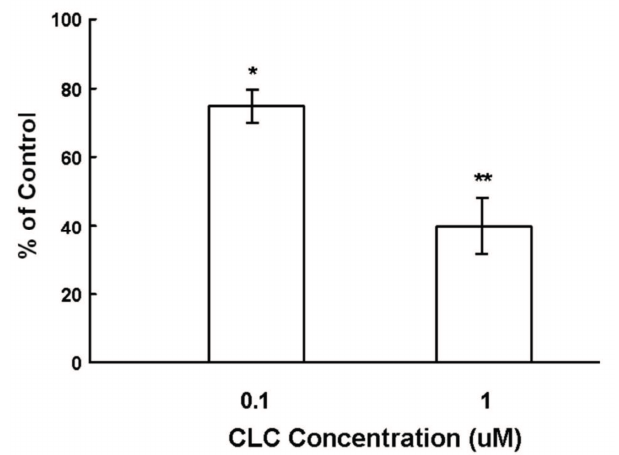
Figure 1. Colchicine (CLC) inhibited the ex vivo elongation of hair fiber. The organ cultured rat vibrissa hair follicles (HFs) were treated with CLC (0.1 and 1 µM) for seven days and the length of HF fiber was determined. The vibrissa HFs with DMSO treatment was taken as control (100%). Data were expressed as the mean from three batch triplicate experiments; bars , ±SD. * p < 0.05, ** p < 0.01 vs. control